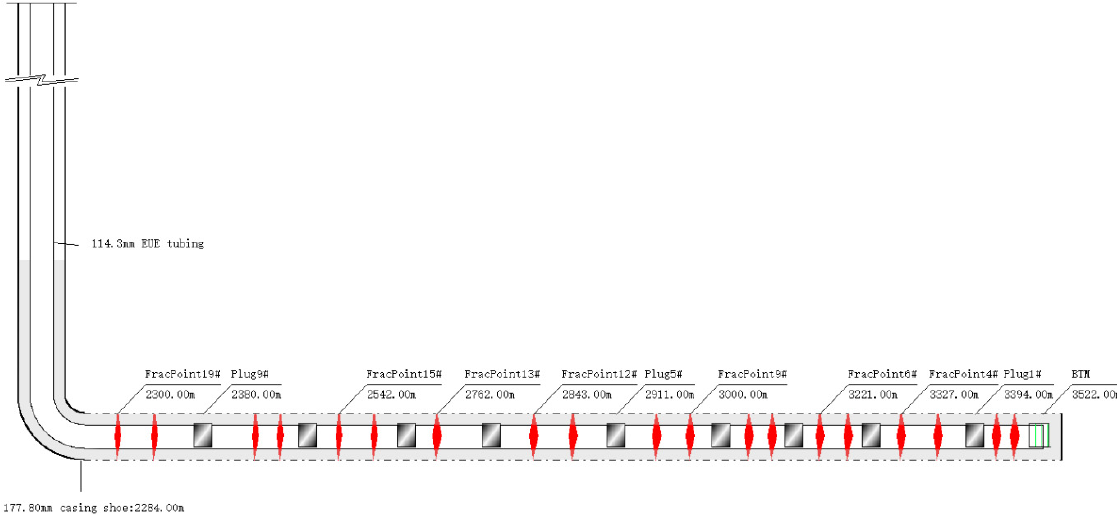
Figure 6. Schematic of perf-and-plug multistage fracturing completion string.